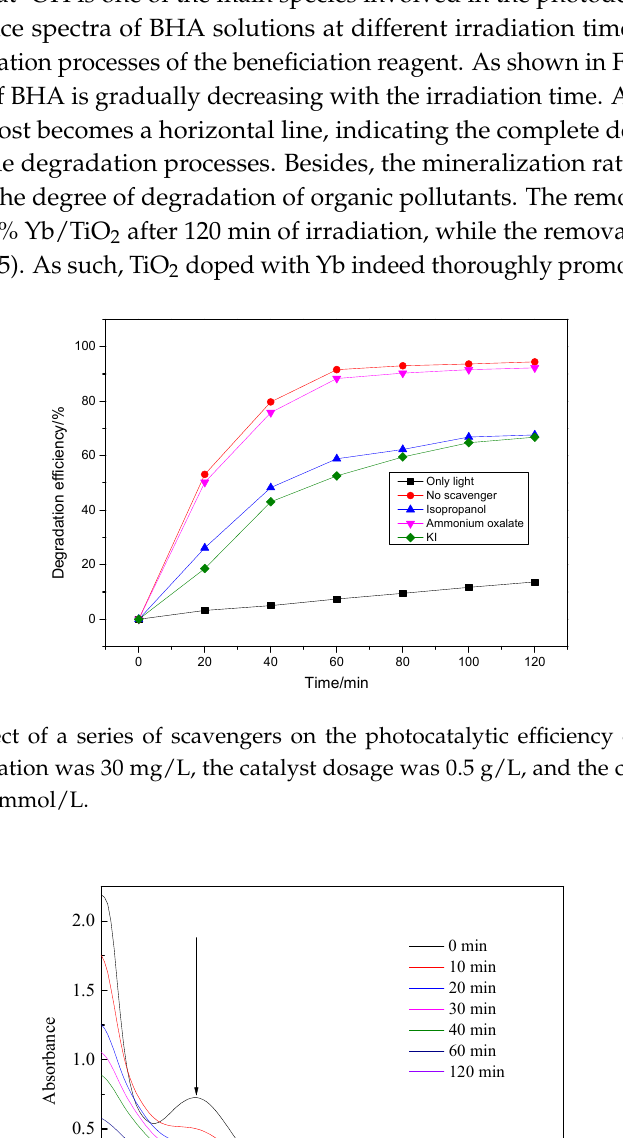
4 Figure 9. Changes in NO 3 − and NO 2 − concentrations in the photocatalytic degradation of benzohydroxamic acid by 0.50% Yb/TiO 2 . 3.4. Calculations and Interfacial Charge Transfer Processes The calculated band structure of anatase TiO 2 (unit cell) exhibits an indirect band gap of 2.105 eV (Figure 10), which is lower than the experimental values, but the electronic structure is otherwise essentially the same [35]. For the doped structure, a supercell of 2 × 2 × 1 48-atom anatase TiO 2 was used, and one Ti atom near the centre of the supercell was replaced by one Yb atom. The calculated band structure of doped TiO 2 is 2.029 eV, which is lower than for pure TiO 2 , and is consistent with the experimental results in this study.